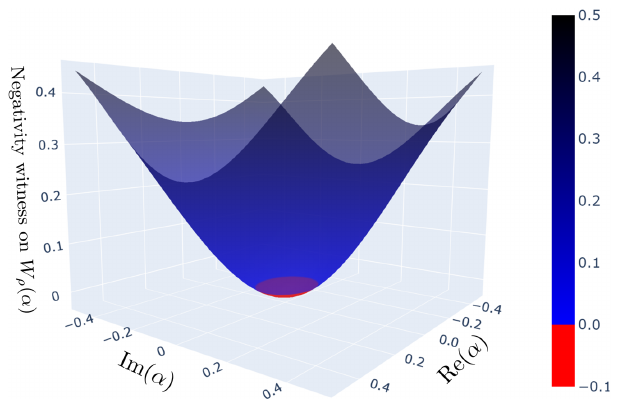
FIG. 5. Negativity witnesses for a photon-subtracted squeezed vacuum state with 3 dB of squeezing and 0.95 preparation purity. Using simulated samples from double homodyne detection, the witnesses in Eq. (12) are estimated for a thousand values of the displacement amplitude α , which are interpolated for clarity, with a fixed precision (cid:9) = 0.1 and a fixed number of samples N = 5.5 × 10 5 . The curve is shifted upwards by the value of (cid:9) , and the red points witness the negativity of the state with at least 98%